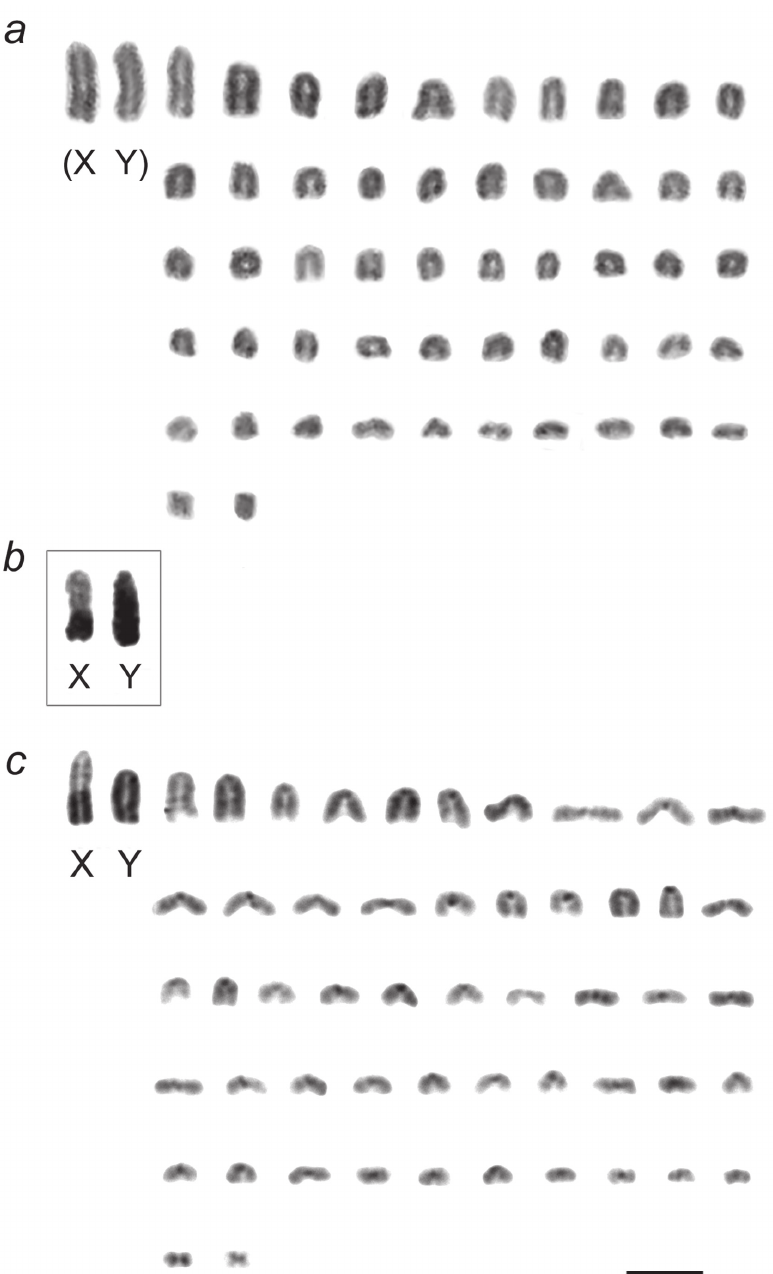
Figure 2a-b. Mitotic chromosomes of East Siberian and East European M. rossiaemeridionalis : a conven- tionally stained chromosomes of the male from Olkhon Island arranged by size, with provisional identifi- cation of the XY sex chromosome pair, based on chromosome length b C-banded sex chromosomes of the same individual c C-banded chromosomes of a male from the east bank of the river Volga. Bar=10